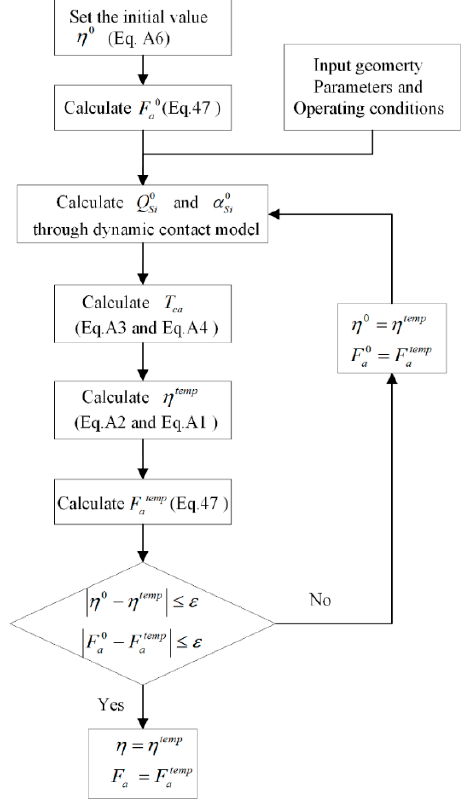
Figure A1. Algorithm flow chart of calculating the transmission efficiency.